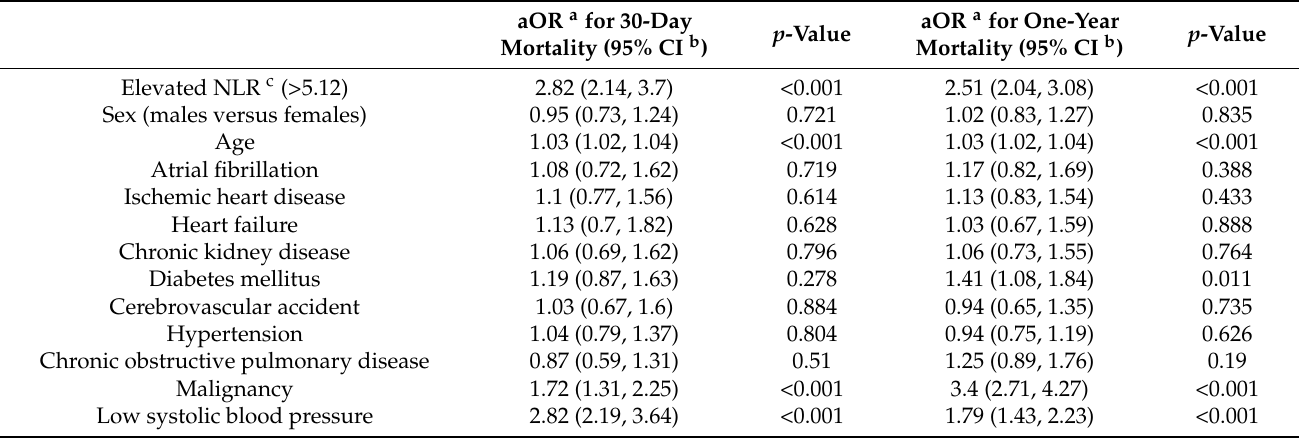
aOR a for One-Year aOR a for 30-Day p -Value p -Value Mortality (95% CI b ) Mortality (95% CI b )